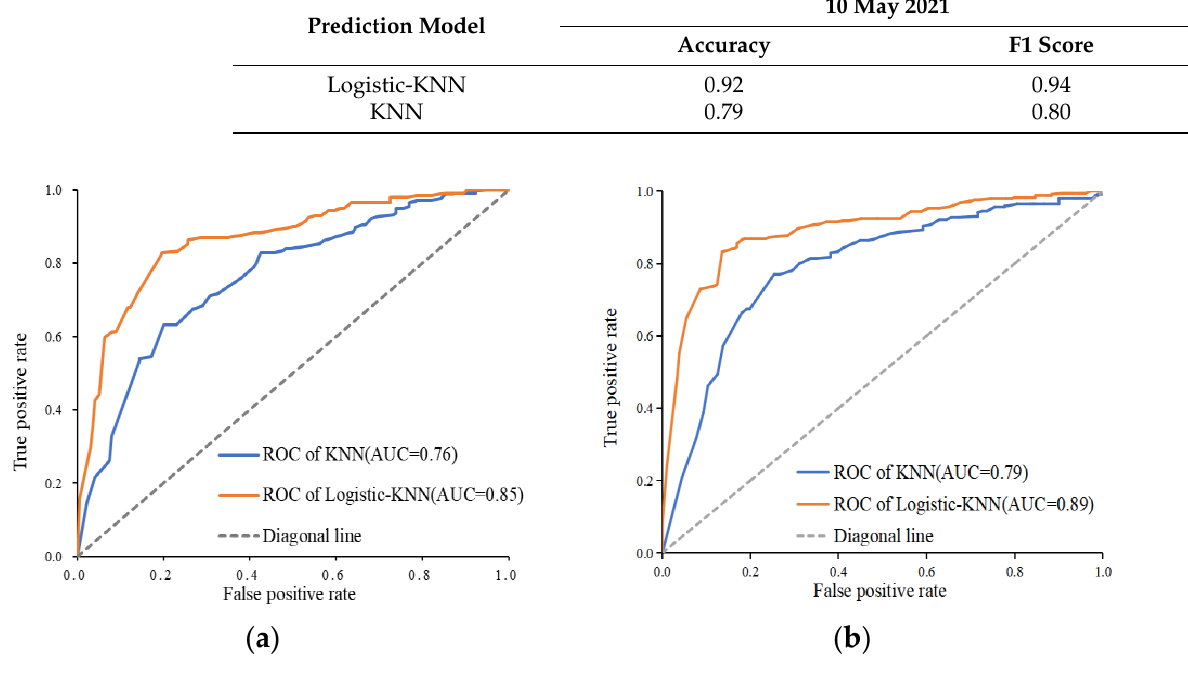
Figure 5. Average ROC curves and their corresponding AUC values: ( a ) 29 April 2021; ( b ) 10 May 2021.